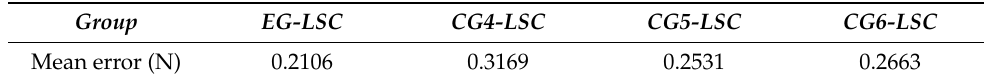
Figure 13. Final results of different algorithm. Table 5. Mean errors of each method.